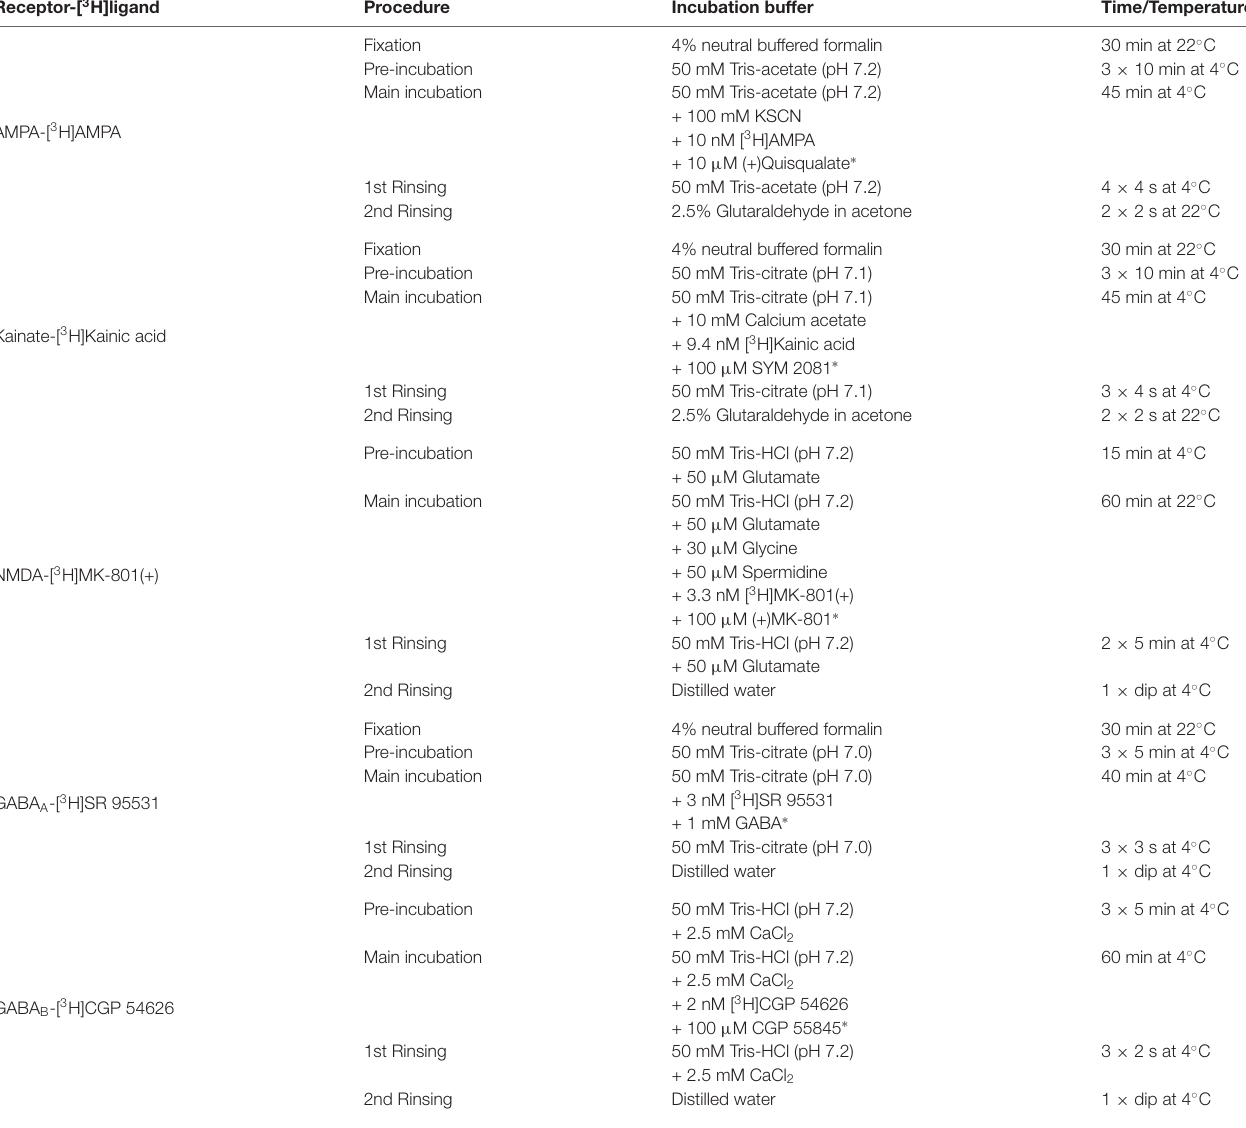
TABLE 1 | Receptor binding protocols for glutamatergic and GABAergic [ 3 H]ligands, including displacer (marked with ∗ ) and incubation conditions. Receptor-[ 3